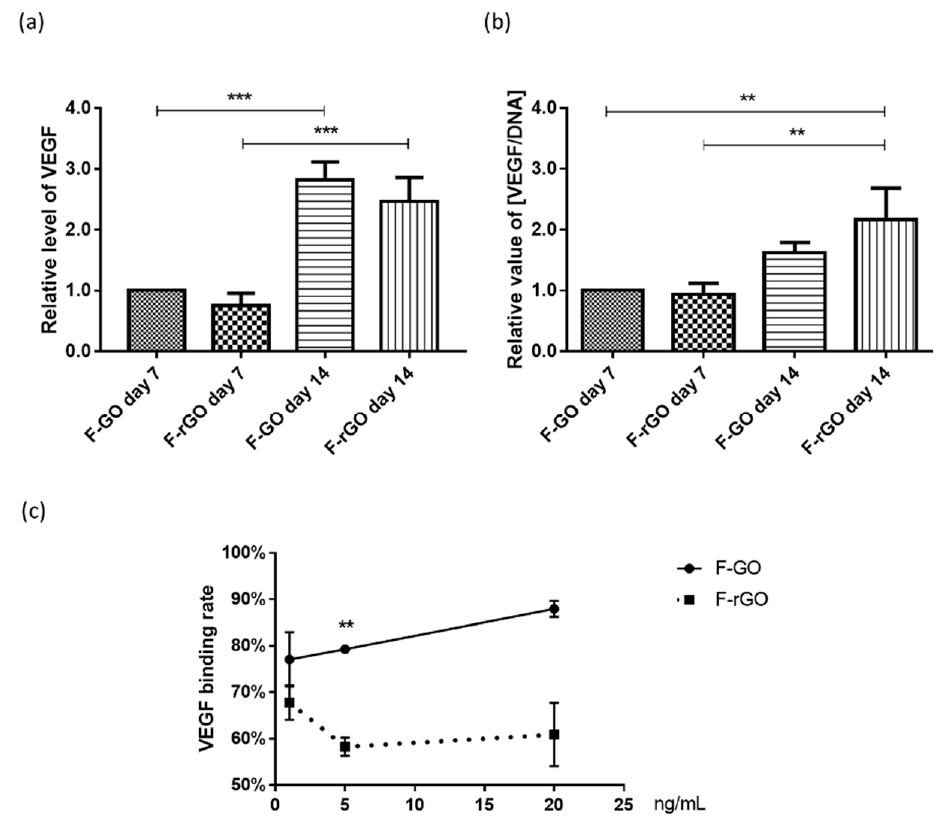
Figure 2. VEGF levels and binding capacities for F-GO and F-rGO. ( a ) Relative level of VEGF in the supernatant of MSC mono-cultures on F-GO or F-rGO on day 7 and 14, measured with enzyme-linked immunosorbent assay (ELISA). ( b ) VEGF level normalized to DNA content in relation to F-GO on day 7 for both time points. One-way ANOVA. ** p < 0.01, *** p < 0.001, n = 3 Donors of MSC. ( c ) VEGF binding rate for F-GO and F-rGO framework structures (in % of added concentration). t -test, ** p < 0.01, n = 3.